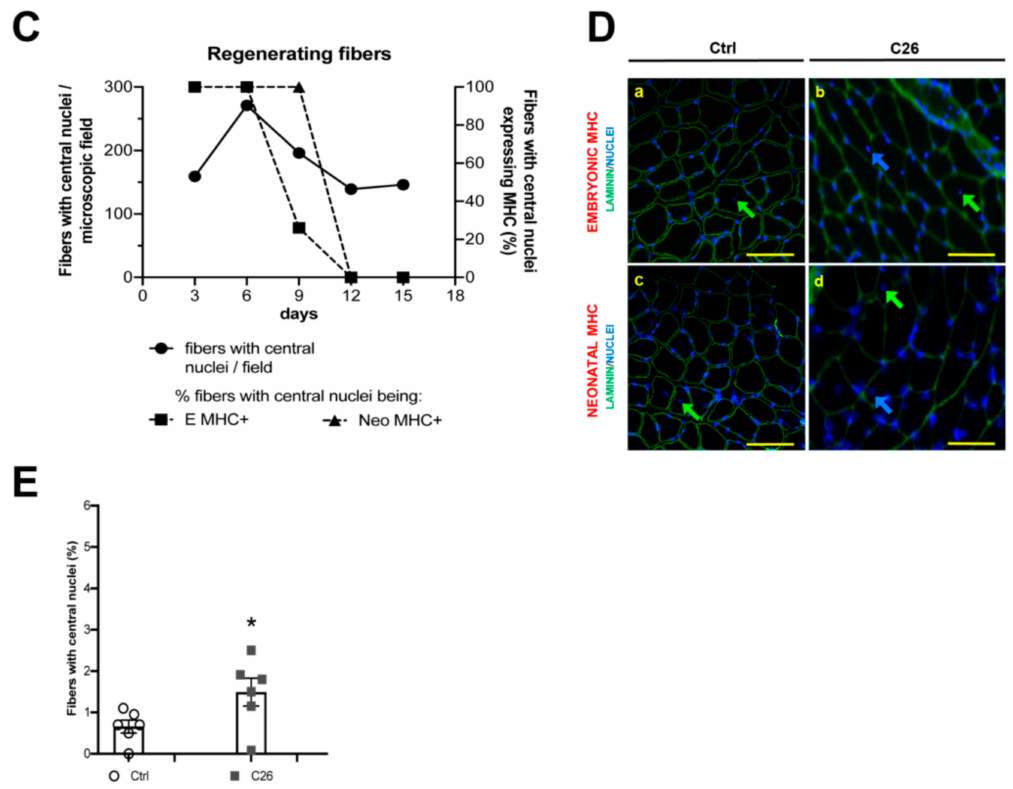
Figure 1. Myofibers with central myonuclei do not express bona fide early regeneration markers in the tibialis of cachectic mice. ( A ) Carcass (i.e. net body weight, minus tutor weight) ( a ) and tibialis anterior (TA) muscle ( b ) weight in control (Ctrl) and in tumor-bearing (C26) mice, showing a significant decrease of body and muscle mass in cachexia. Muscle wasting is due to protein dismantling, as shown by the muscle-specific Ub-ligase Atrogin-1 upregulation in cachexia ( c ). For carcass weight ( a ) and Atrogin-1 ( c ) n = 6 for each group; for TA weight n = 12 and n = 25, for Ctrl and C26, respectively; * p < 0.05, by Student’s t test. ( B ) Photomicrographs of TA muscle at 3, 6, 9, 12 and 15 days (D3 to D15) following freeze injury, immunostained for embryonic ( a – e ) or neonatal ( f – j ) MHC (red); nuclei are counterstained by Hoechst (blue), while laminin immunostaining (green) highlights muscle fibers. Embryonic MHC + and MHC- fibers with central myonuclei are indicated by white arrows ( a , b , c , f , g , h ) or blue and green arrows ( d , e , i , j ), respectively. ( C ) Quantification of muscle fibers showing central myonuclei and expressing embryonic MHC. These fibers stop expressing the regeneration markers at D9. ( D ) Photomicrographs of TA muscle immunostained for embryonic ( a and b ) or neonatal ( c and d ) MHC (red) and laminin (green), in control ( a , c ) and C26-tumor bearing ( b , d ) mice; nuclei are counterstained by Hoechst (blue). Fibers with central myonuclei, negative for either type of MHC, are indicated by blue or green arrows (in the first case the nucleus is just displaced from its subsarcolemmal position, while in the second case it is closer to the center of the fiber). Scale bar is 50 µ m. ( E ) Quantification of the fibers with central myonuclei observed in